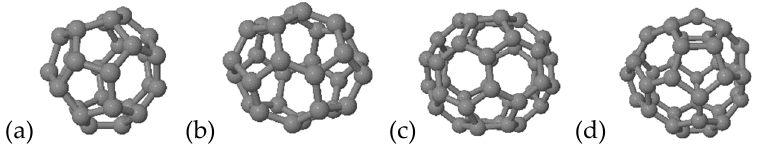
Figure 2. Structures for all site test. ( a ) C 28 (1- T d ), ( b ) C 28 (2- D 2 ), ( c ) C 40 (38- D 2 ), and ( d ) C 40 (40- T d ).